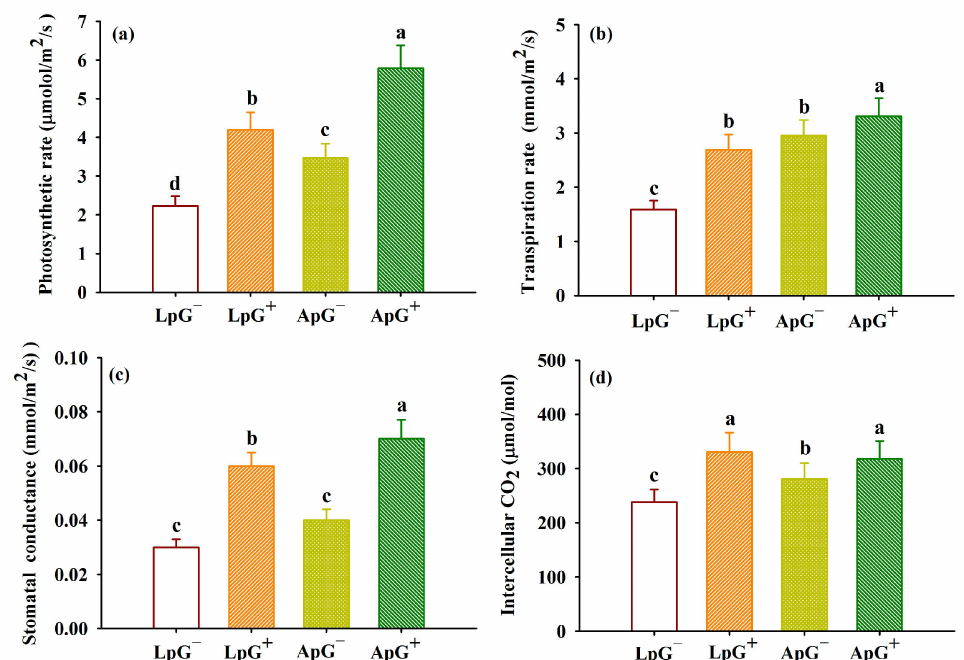
Figure 3. Changes in leaf photosynthetic rate ( a ), transpiration rate ( b ), stomatal conductance ( c ), and intercellular CO 2 concentrations ( d ) of Polygonum cuspidatum inoculated with Glomus mosseae in low and approximate P levels. Different letters on the bars indicate significant differences between treatments at the 0.05 level. See Figure 1 for abbreviations.